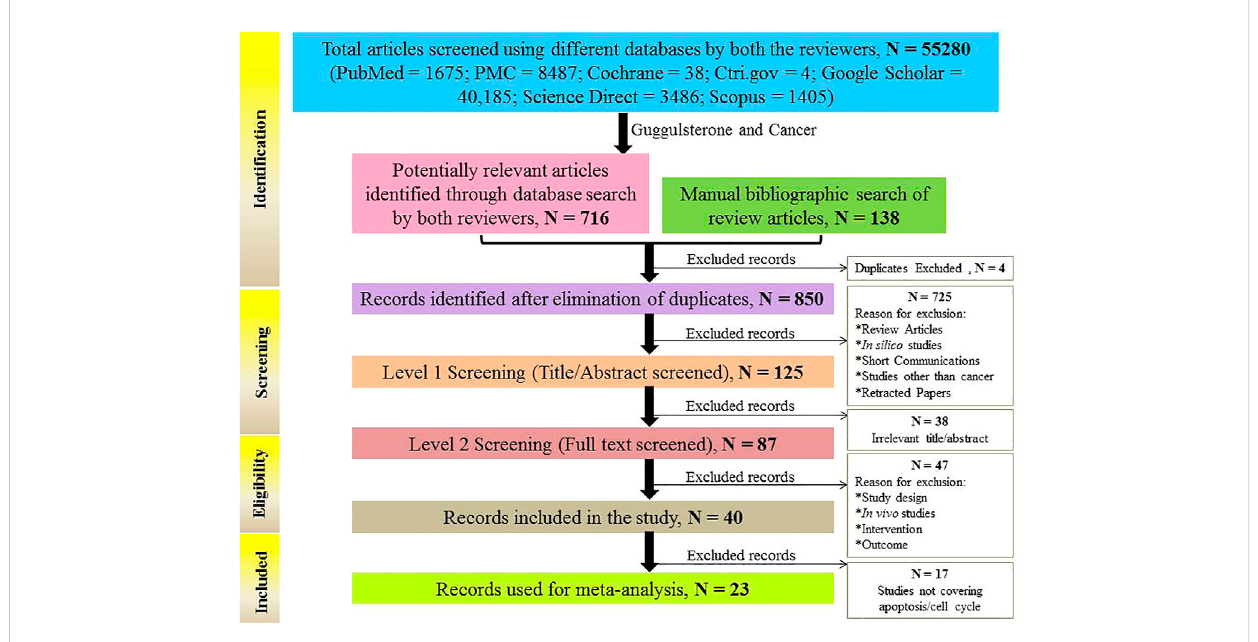
FIGURE 3 Flow chart explaining the selection process of studies ( in vitro ) included in the